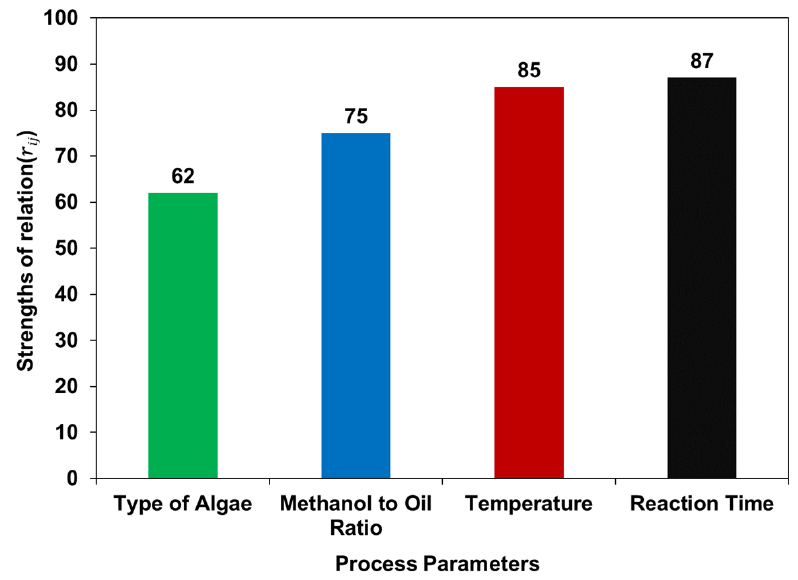
Figure 10. Sensitivity of process parameters in biodiesel production.